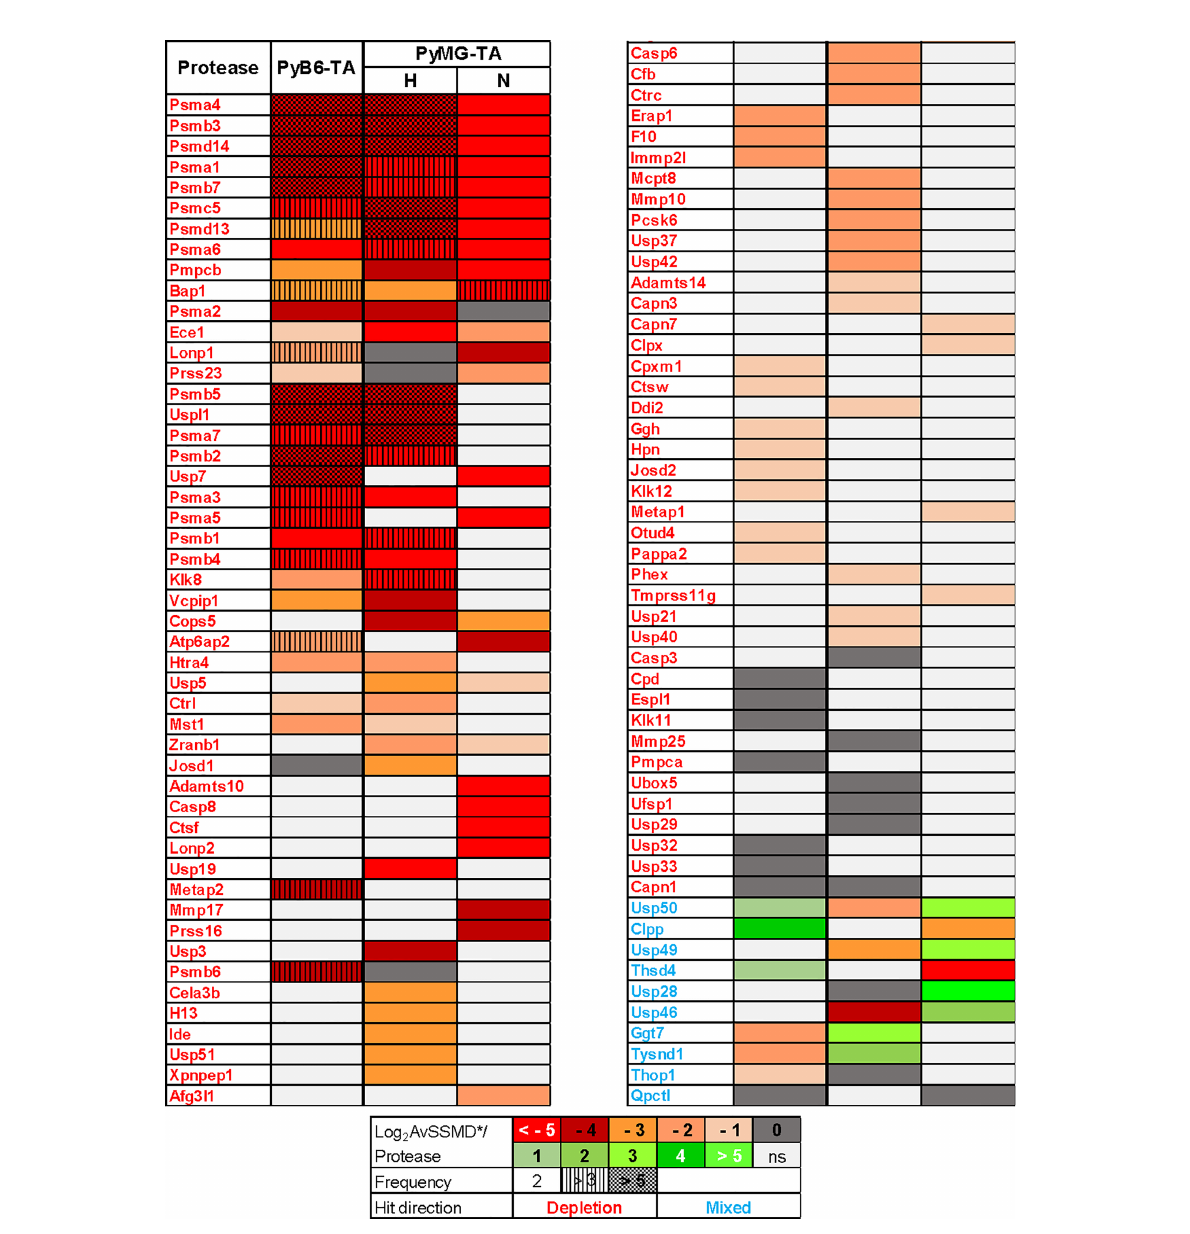
FIGURE 5 Competitive growth screen hits. Heat map of the competitive growth screen hits performed in miR-E library-transduced PyB6-TA or PyMG-TA cells cultured under 3% O 2 hypoxic (H) or 21% O 2 normoxic (N) culture conditions. Log 2 AvSSMD*/protease as color code. Light gray (ns): not signi fi cant due to preselection criteria 1 ( ≥ 2 miR-Es/protease outside ±1 SD_AvSSMD*, fi ltered for suf fi cient target mRNA expression in both cell lines). Hit direction: red names (depletion); blue names (mixed). Frequency: number of miR-Es/protease outside ±1 SD_AvSSMD*. The term protease referred to all degradome-encoded proteins including proteases, protease-like proteins, and protease